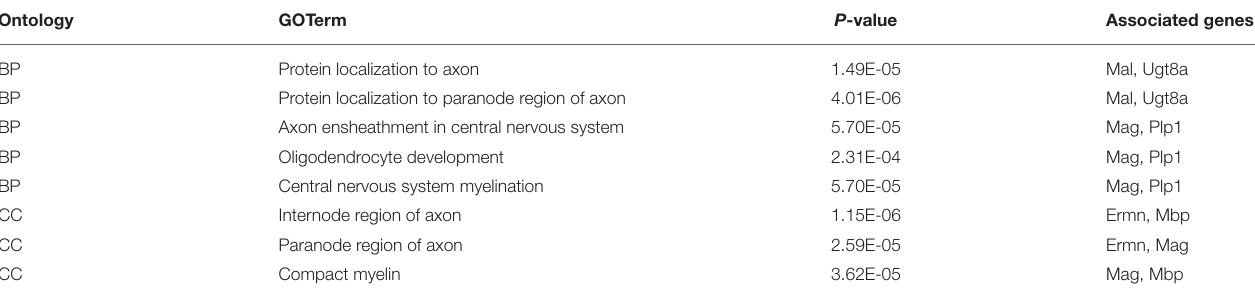
TABLE 3 | GO annotation on the 10 hub genes in F and E/RE groups.